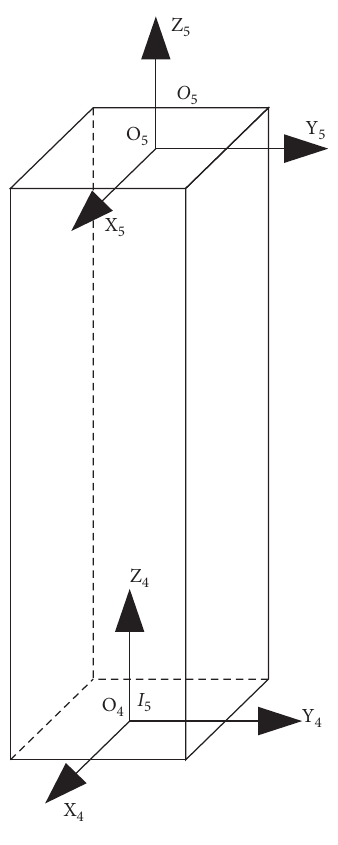
Figure 6: Spatial single-input single-output rigid